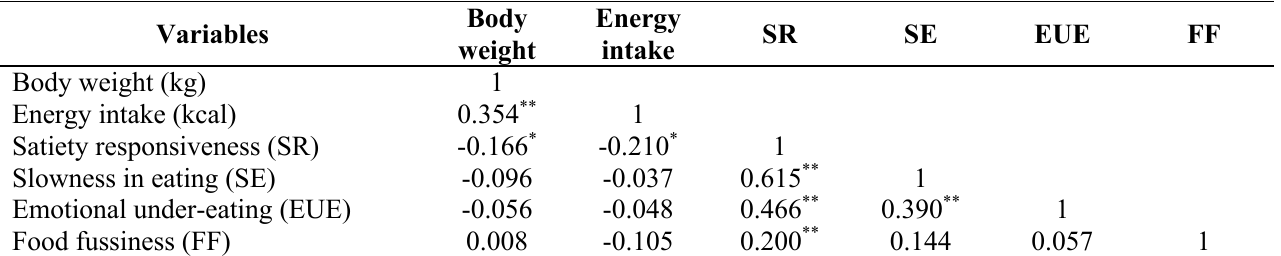
Table 3. Correlation between food avoidance scales with child’s weight and energy intake